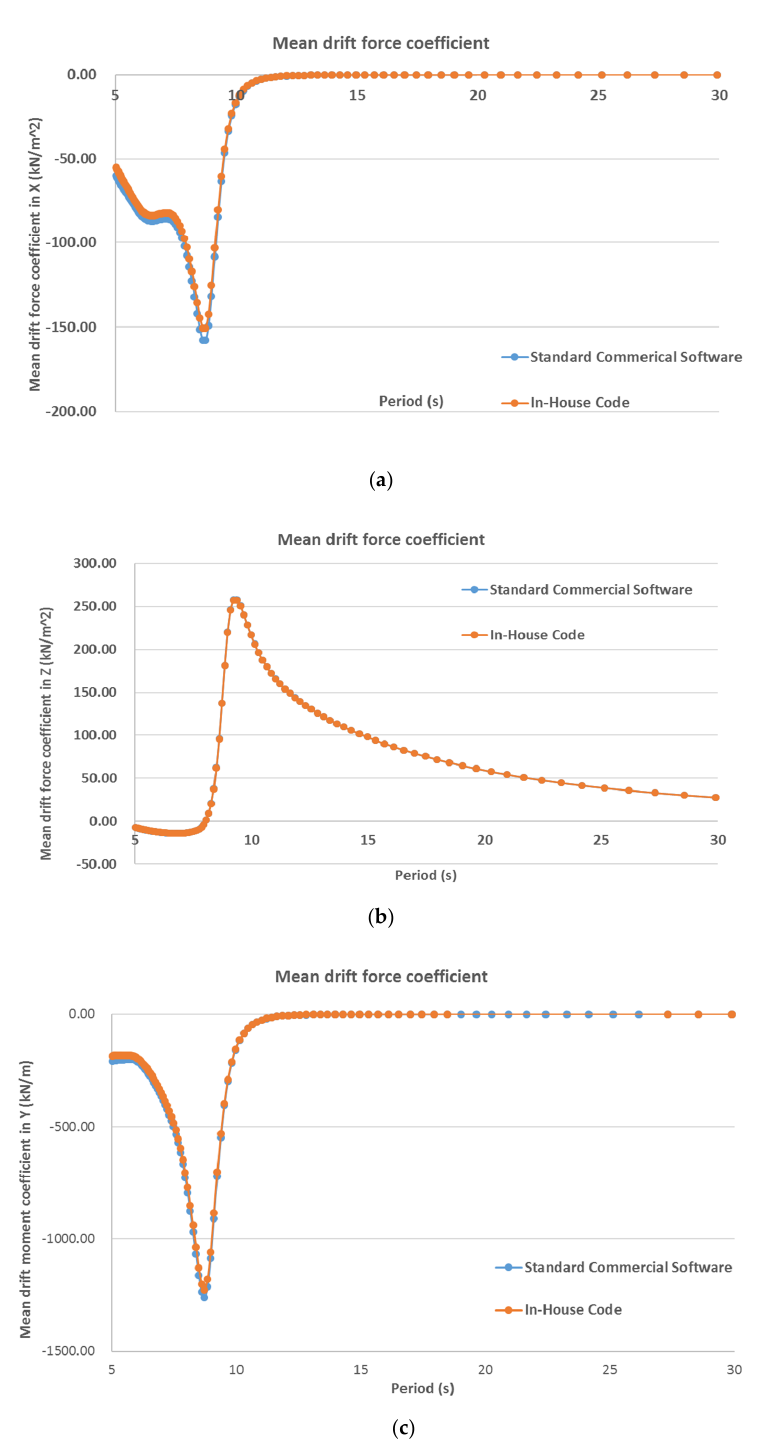
Figure 3. The comparison of the mean drift force coefficients with the standard commercial software: ( a ) Amplitude of the mean drift force in X direction (kN/m 2 ); ( b ) Amplitude of the mean drift force in Z direction (kN/m 2 ); ( c ) Amplitude of the mean drift moment in Y direction (kN/m).